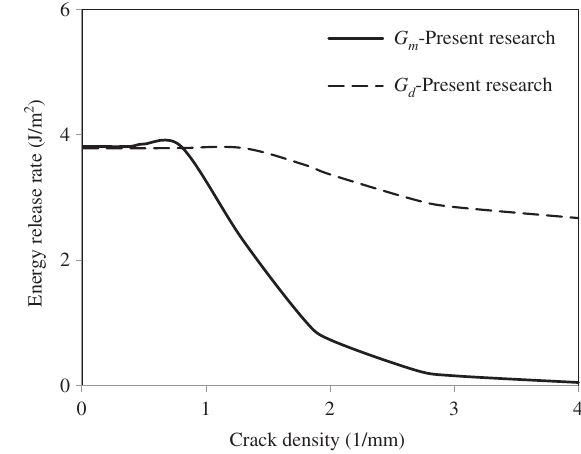
] s carbon/ Figure 9: Crack density vs. energy release rate for [0/90] s carbon/ 2